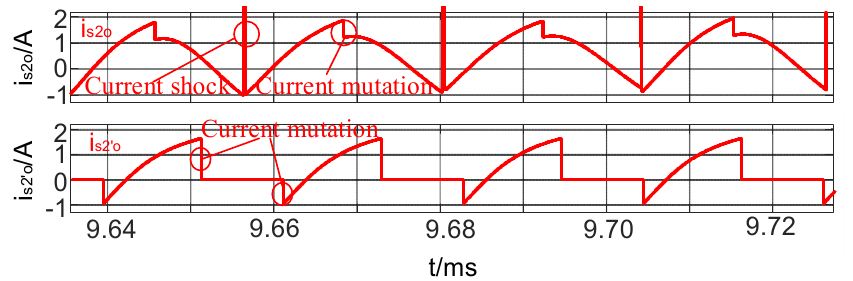
Figure 12. The input-current waveform of traditional in parallel resonance circuit on load mode .